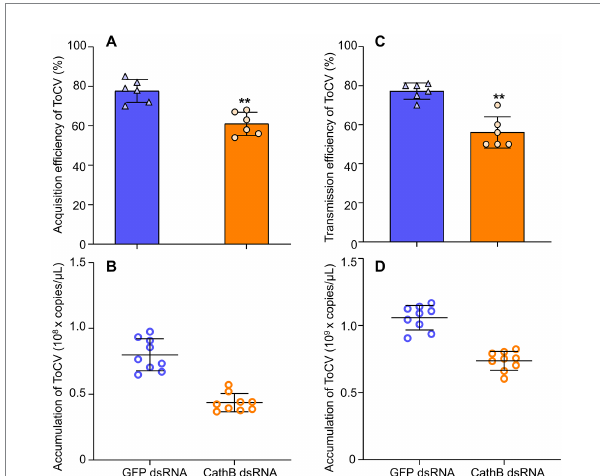
FIGURE 8 The effects of dsRNAs on acquisition and transmission in B. tabaci MED. (A) Acquisition rate of ToCV by B. tabaci MED with dsRNAs treatment. (B) ToCV accumulation of B. tabaci MED with dsRNAs treatment. (C) Transmission rate of ToCV by B. tabaci MED with dsRNAs treatment. (D) ToCV accumulation of in tomato plants exposed to B. tabaci MED with dsRNAs treatment. GFP dsRNA, control group; CathB dsRNA, treatment group. Data are denoted as mean ± SE. *** indicates a significant difference at p < 0.001; ** indicates a significant difference at p < 0.01; * indicates a significant difference at p <